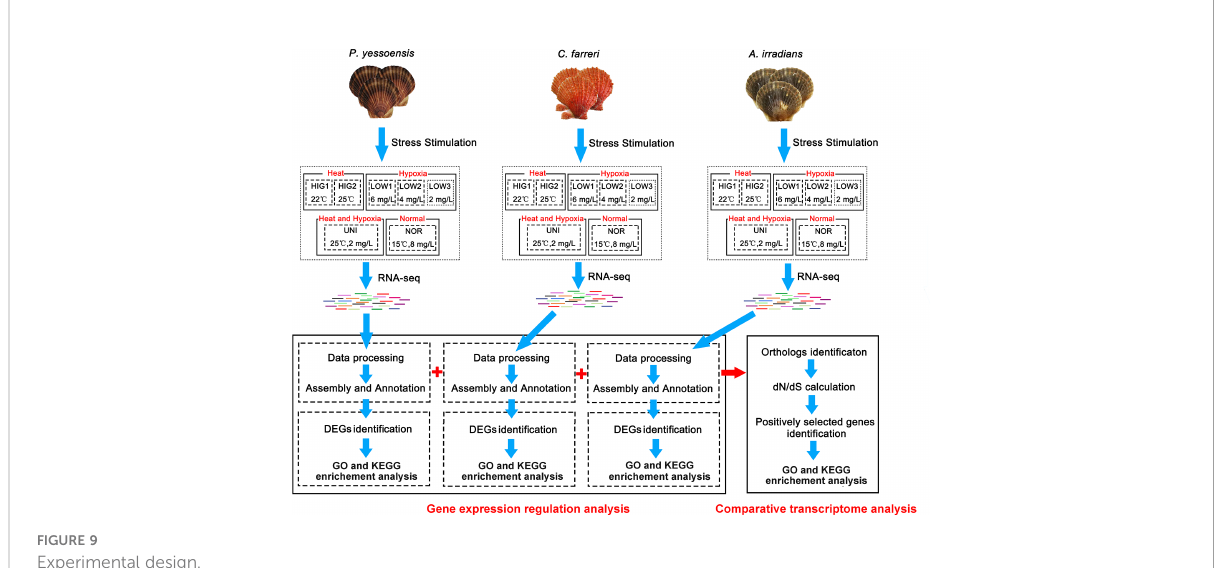
FIGURE 9 Experimental